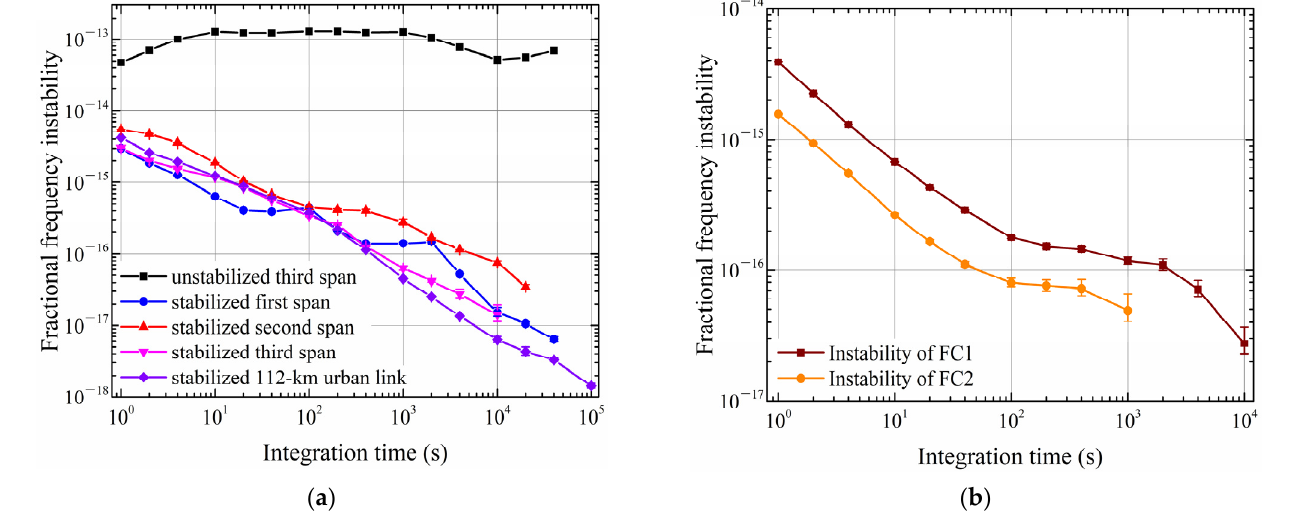
Figure 6. Transfer instability of 100-km single-span link and frequency conversion module. ( a ) Instability of 100-km single-span link; ( b ) Instability of frequency conversion module.